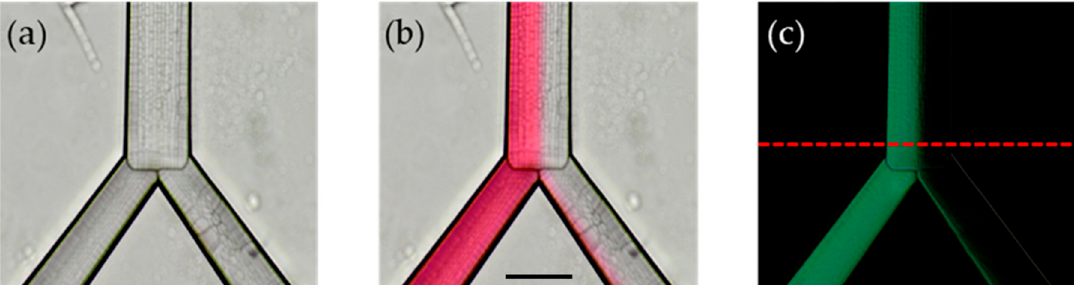
Figure 2 . Visual analysis technique of laser-fabricated microfluidic chip: ( a ) reference image, ( b ) colored image with the flowing dye solution; ( c ) negative image obtained by subtracting ( a ) from ( b ). The red dashed line indicates the output of the chip position chosen to extract the intensity profile. Scale bar corresponds to 200 μ m.